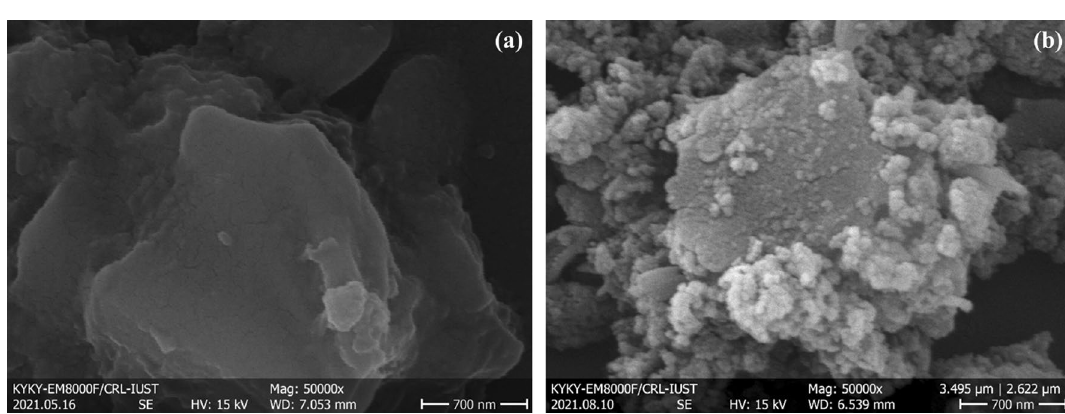
Figure 4. FE-SEM image of ( a ) CN and ( b )